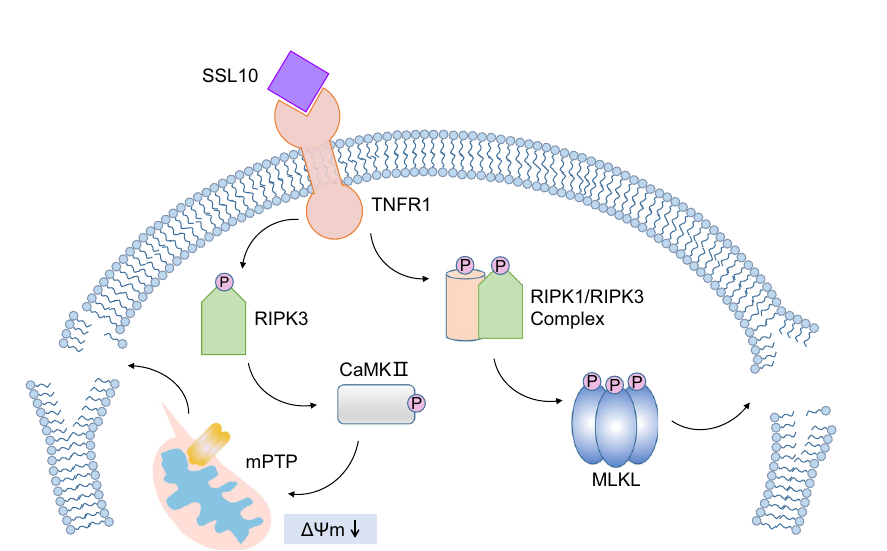
Fig. 6 Identi fi cation of a potential binding interface between SSL10 and TNFR1. a Immunoblotting of SSL10 after pull-down with MBP-TNFR1 ECD or its four deletion mutants (i.e., Δ CRD1-4). The relative band intensities of SSL10 proteins pulled down by WT or mutant MBP-TNFR1 ECD are quantitated by densitometry after normalization to their input, and then expressed as the fold of WT SSL10 pulled down by WT MBP-TNFR1 ECD . b ITC assays of SSL10 binding to the TNFR1 ECD mutant Δ CRD1 or Δ CRD2. c LDH released from HUVEC cells treated with 2 μ M SSL10 alone or combined with 10 μ M MBP- TNFR1 ECD , Δ CRD1 or Δ CRD2, as indicated. d Model 1 of SSL10/TNFR1 ECD complex was generated by HawkDock program with the crystal structures of SSL10 and TNFR1 ECD (PDB code: 1EXT). The enlarged view shows the residues of SSL10 predicted to interact with TNFR1 ECD . SSL10 and TNFR1 ECD are colored cyan and light brown, respectively. e The electrostatic surface view of predicted binding site of SSL10 for TNFR1 ECD is shown. The positive and negative charge are colored blue and red, respectively. f Immunoblotting of SSL10 and its mutants (M1 and M2) after pull-down with MBP-TNFR1 ECD . g ITC assay of mutant M1 binding to MBP-TNFR1 ECD . h LDH released from HEK293T cells treated with 2 μ M SSL10 or mutant M1. All data represent the means ± SD calculated from three independent experiments. * p < 0.05; ** p < 0.01, *** p < 0.001 compared to the Ctrl cells (buffer-treated cells) or as indicated. n.s. not signi fi cant, by one-way ANOVA.